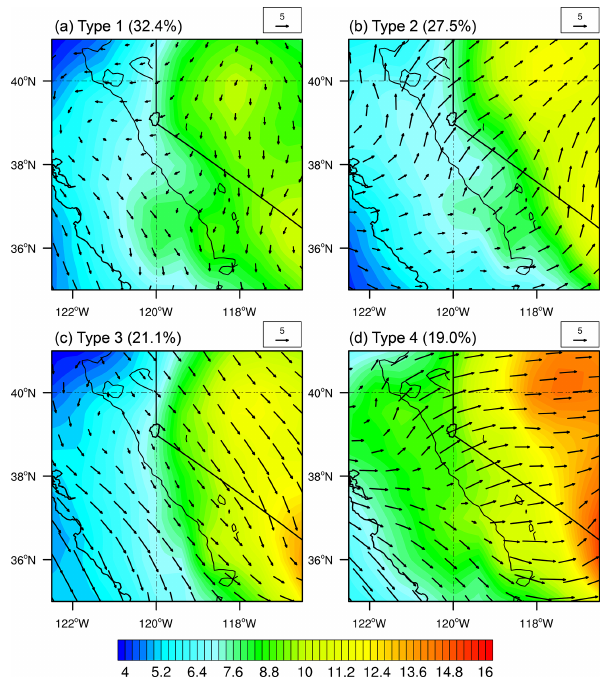
Figure 13. Low-level dust concentration (ugm − 3 ) and wind vec- tors (ms − 1 ) in each of the four SOM types from MERRA-2 av- eraged over 2001–2021. The numbers on the top right of panels denote the frequency of each